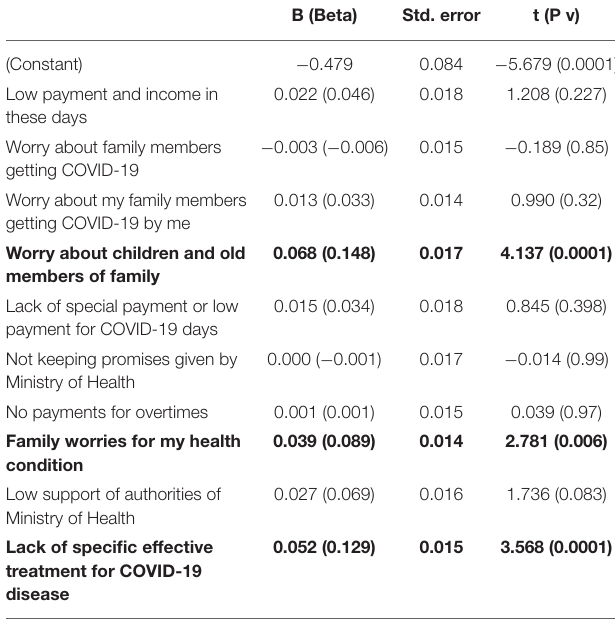
TABLE 5 | Multiple regression model for predicting any mental disorder among the study sample.